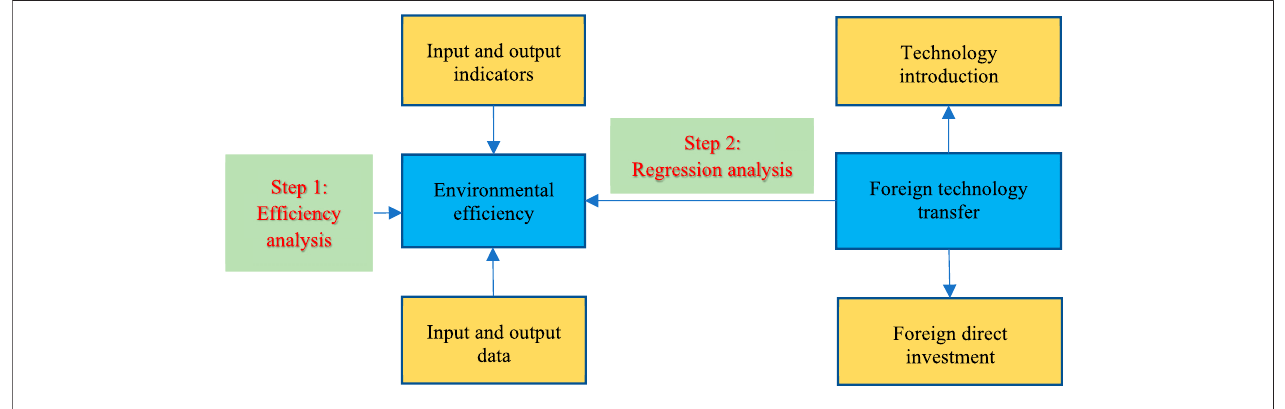
FIGURE 1 | Research